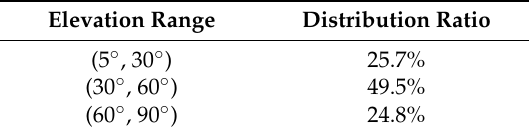
Table 6. Average distribution of the optimal satellite subsets under the greedy method.